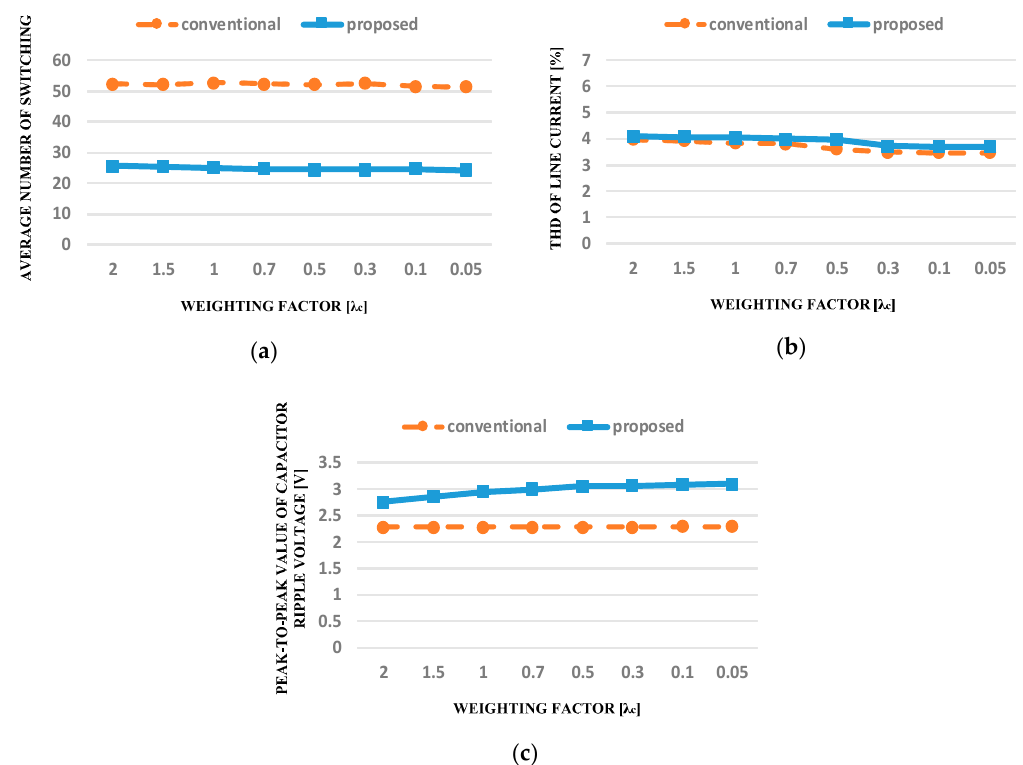
Figure 13. Effects of weighting factor λ c varying from 0.05 to 2 on ( a ) average number of switching ( b ) THD of line current ( c ) peak-to-peak value of capacitor ripple voltage of the conventional and the proposed methods.